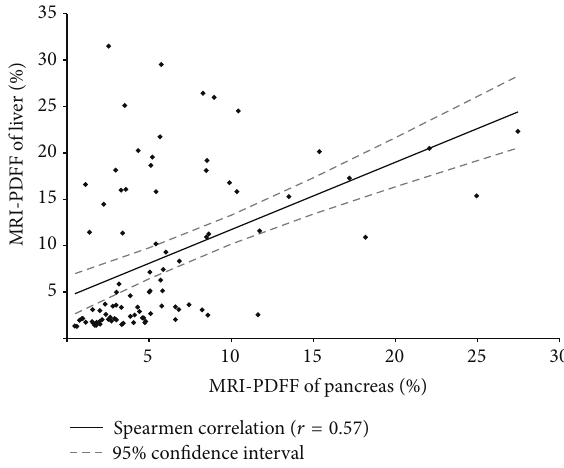
Figure 2: Correlation of MRI-estimated pancreatic fat and liver fat content. Magnetic resonance imaging (MRI) proton-density-fat- fraction (PDFF) of liver ( 𝑦 -axis) and pancreas ( 𝑥 -axis) are shown for all patients in control and NAFLD groups. Spearman correlation coefficient determined with regression line and 95% confidence limits ( 𝑟 2 = 0.32 ) are